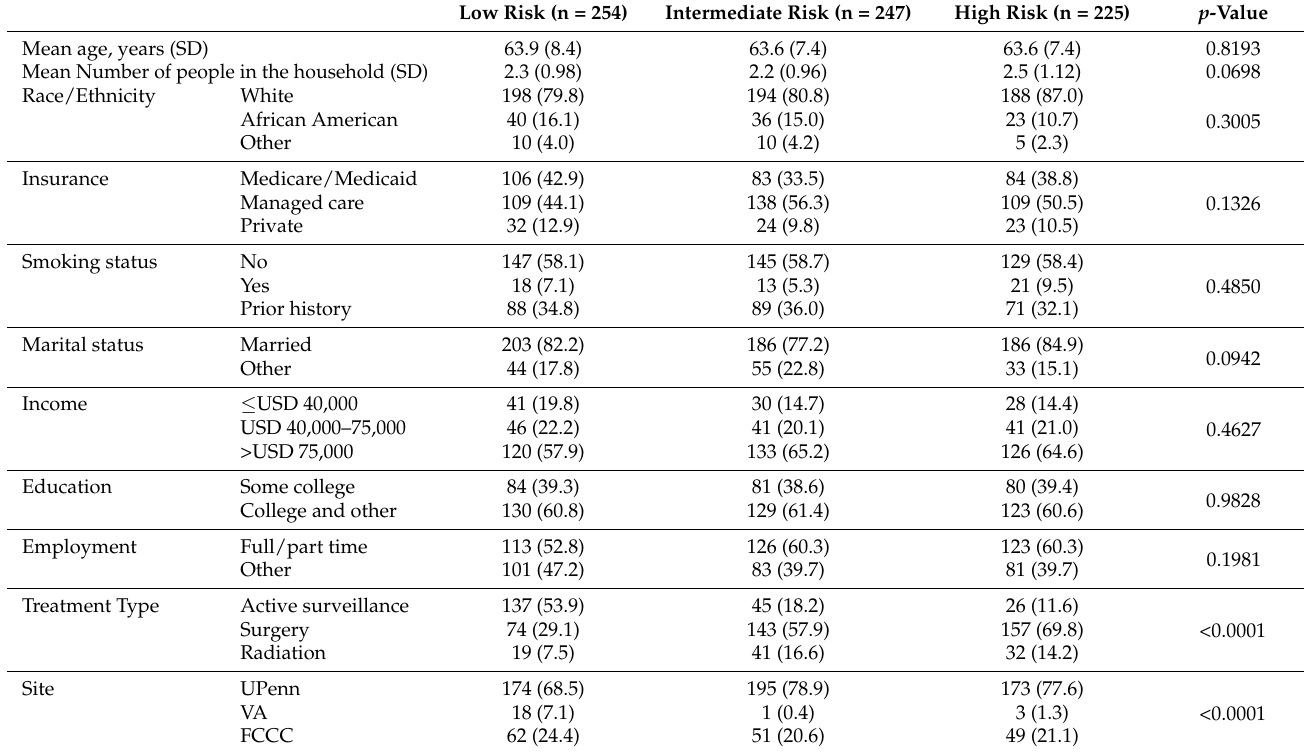
Table 1. Demographics and clinical variables across prostate cancer risk